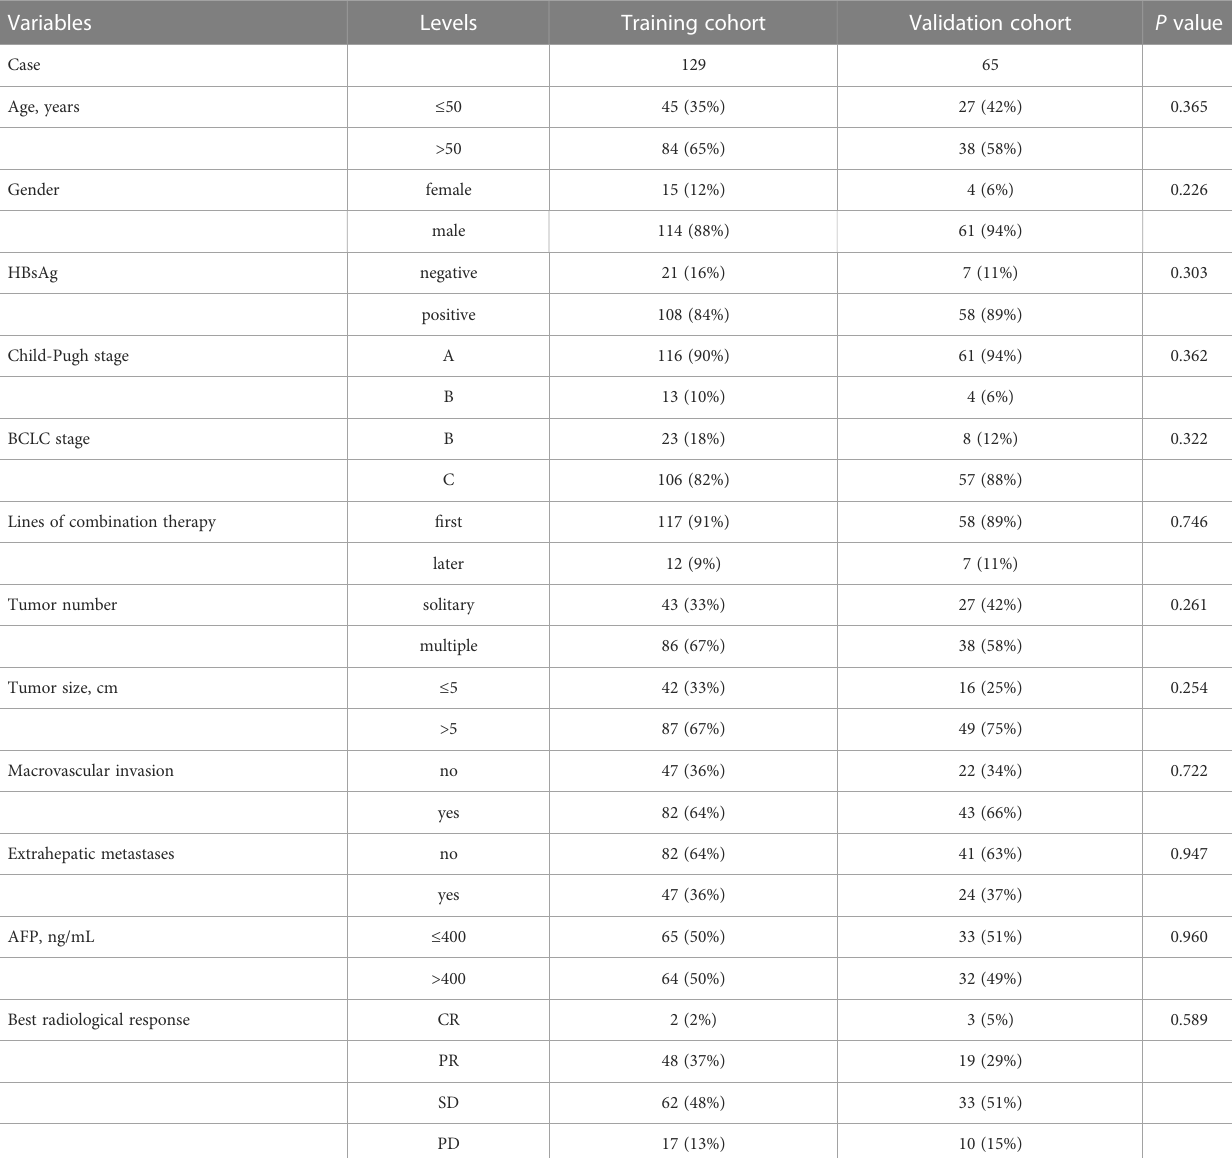
TABLE 1 Clinicopathological characteristics in the training cohort and validation